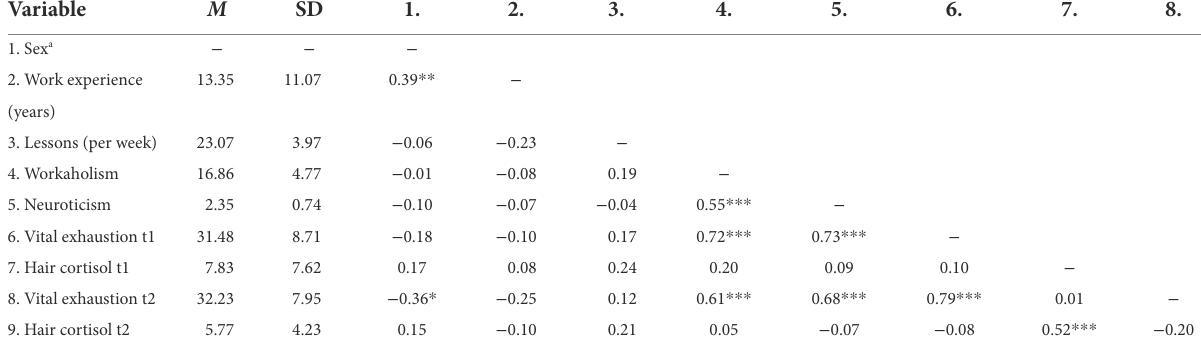
TABLE 1 Descriptive statistics and intercorrelations of the study variables. Variable